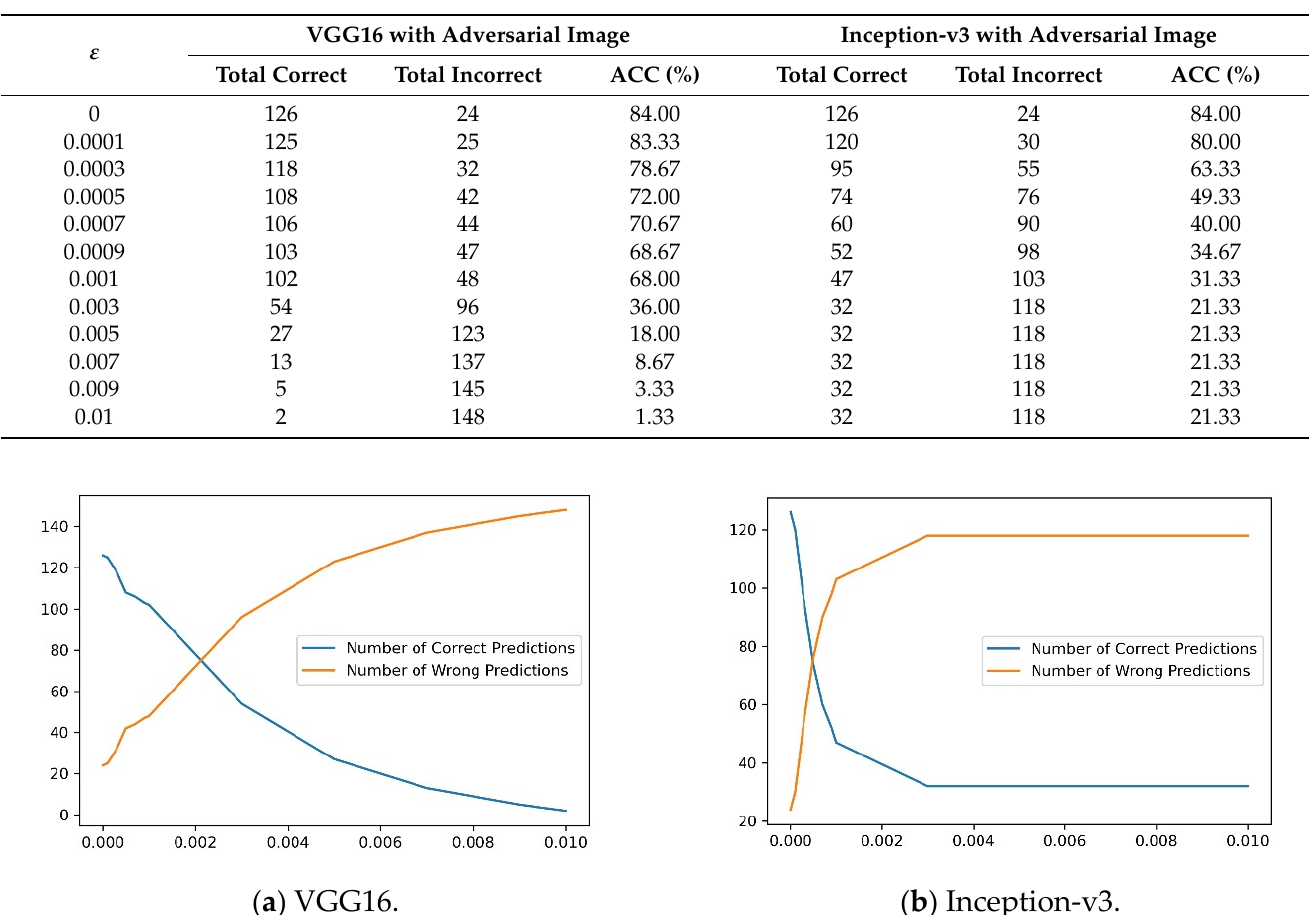
Table 8. Diagnostic performance drop for different ε of FGSM attack in chest CT images.